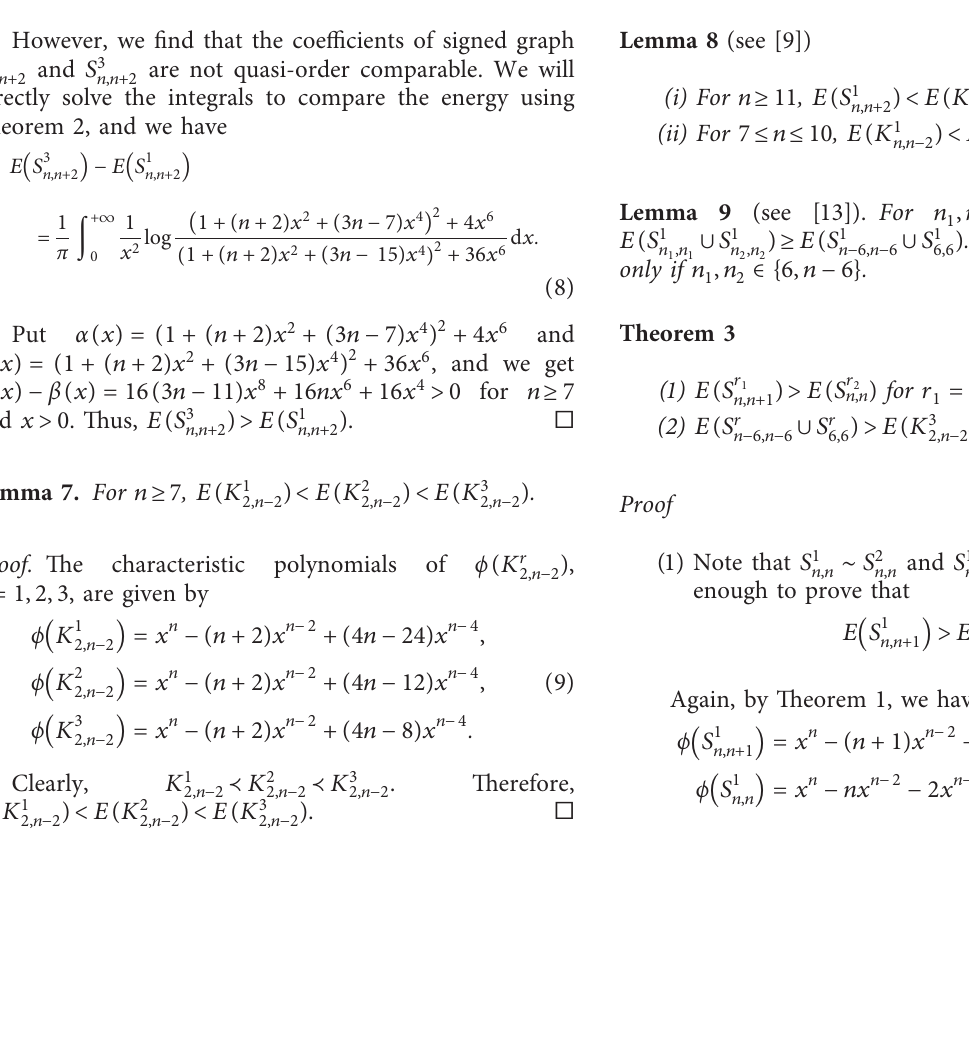
S 3 B 1 n,n + 1 . (b) n,n + 1 . (c) n,n + 1